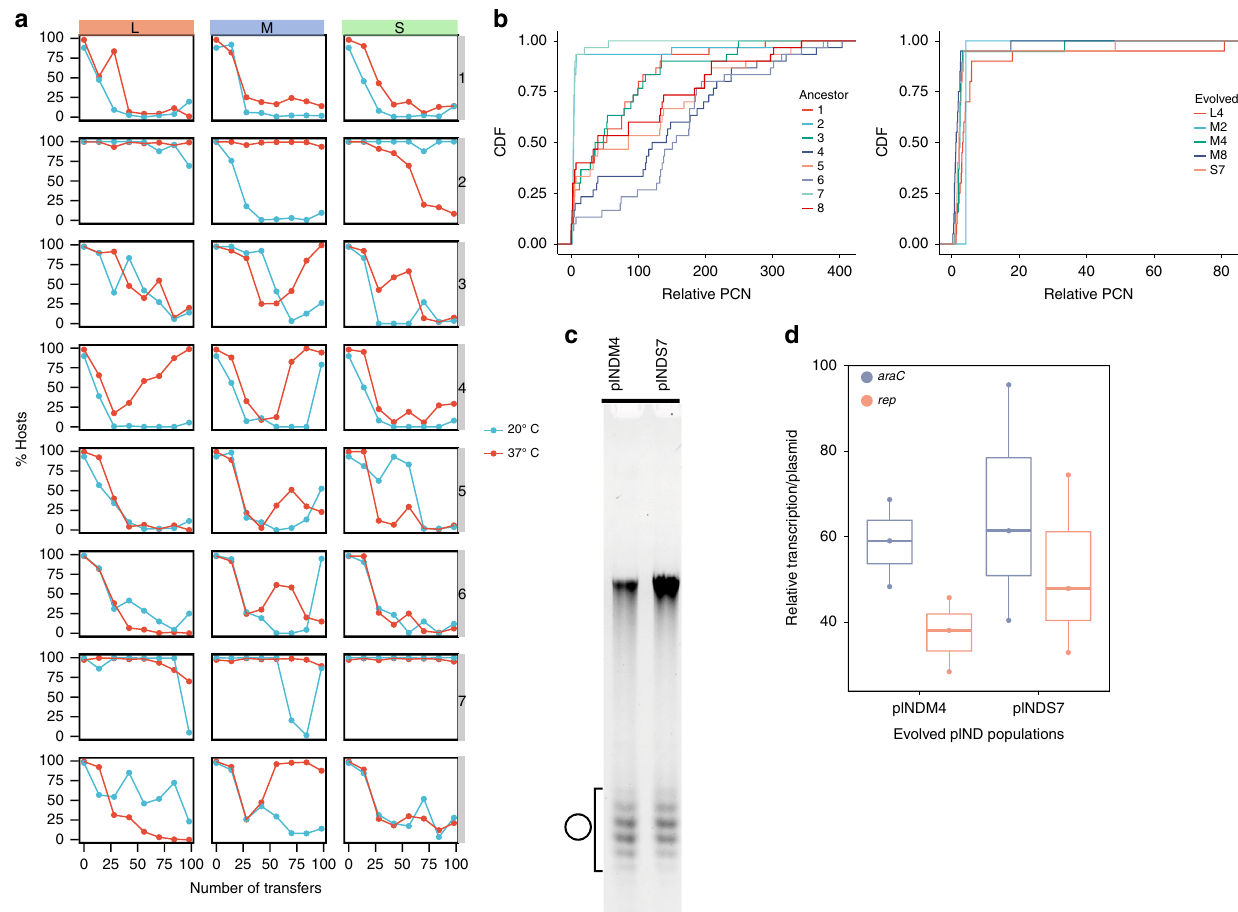
Fig. 4 Evolution of pIND under non-selective conditions. Note that the expression of the plasmid encoded nptII gene was not induced during the evolution experiment. a pIND persistence is shown as the proportion of hosts during the evolution experiment at 20 °C (blue) and at 37 °C (red). The columns correspond to the three population bottleneck sizes (L, M, and S). The experiment was conducted for 98 transfers, which correspond to 600 generations in L populations, 800 generations in M populations, and about 1000 generations in S populations. Eight replicate lines are presented in vertical order (i.e., populations in each row have a common ancestral population). Replicates pIND1 and pIND2 correspond to the replicates presented in Fig. 3. b Cumulative distribution function of relative plasmid copy number (PCN) distribution in pIND ancestral populations (left) and evolved stable populations (right). Replicates correspond to the replicates in the evolution experiment in ( a ) ( n = 30 or n = 20 for each population). c Evolved stable pIND plasmids from populations pINDM4 and pINDS7 (37 °C) analyzed by one-dimensional chloroquine gel electrophoresis (as shown in Fig. 3b, c). Symbol denotes the supercoiled monomer distribution of pIND (Supplementary Figs. 8b and 9b). d Relative transcription per plasmid of pIND from evolved populations pINDM4 and pINDS7 (37 °C, n = 3). The center value of the boxplots represents the median, the boxes denote the interquartile range, and the whiskers represent minimum and maximum values. Source data are provided as a Source Data fi